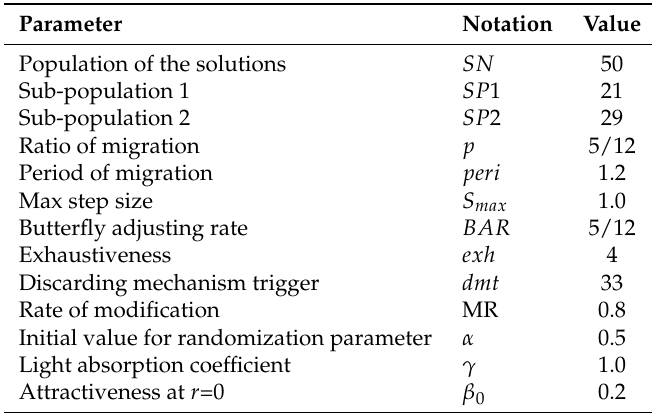
Table 1. MBO-ABCFE parameters.